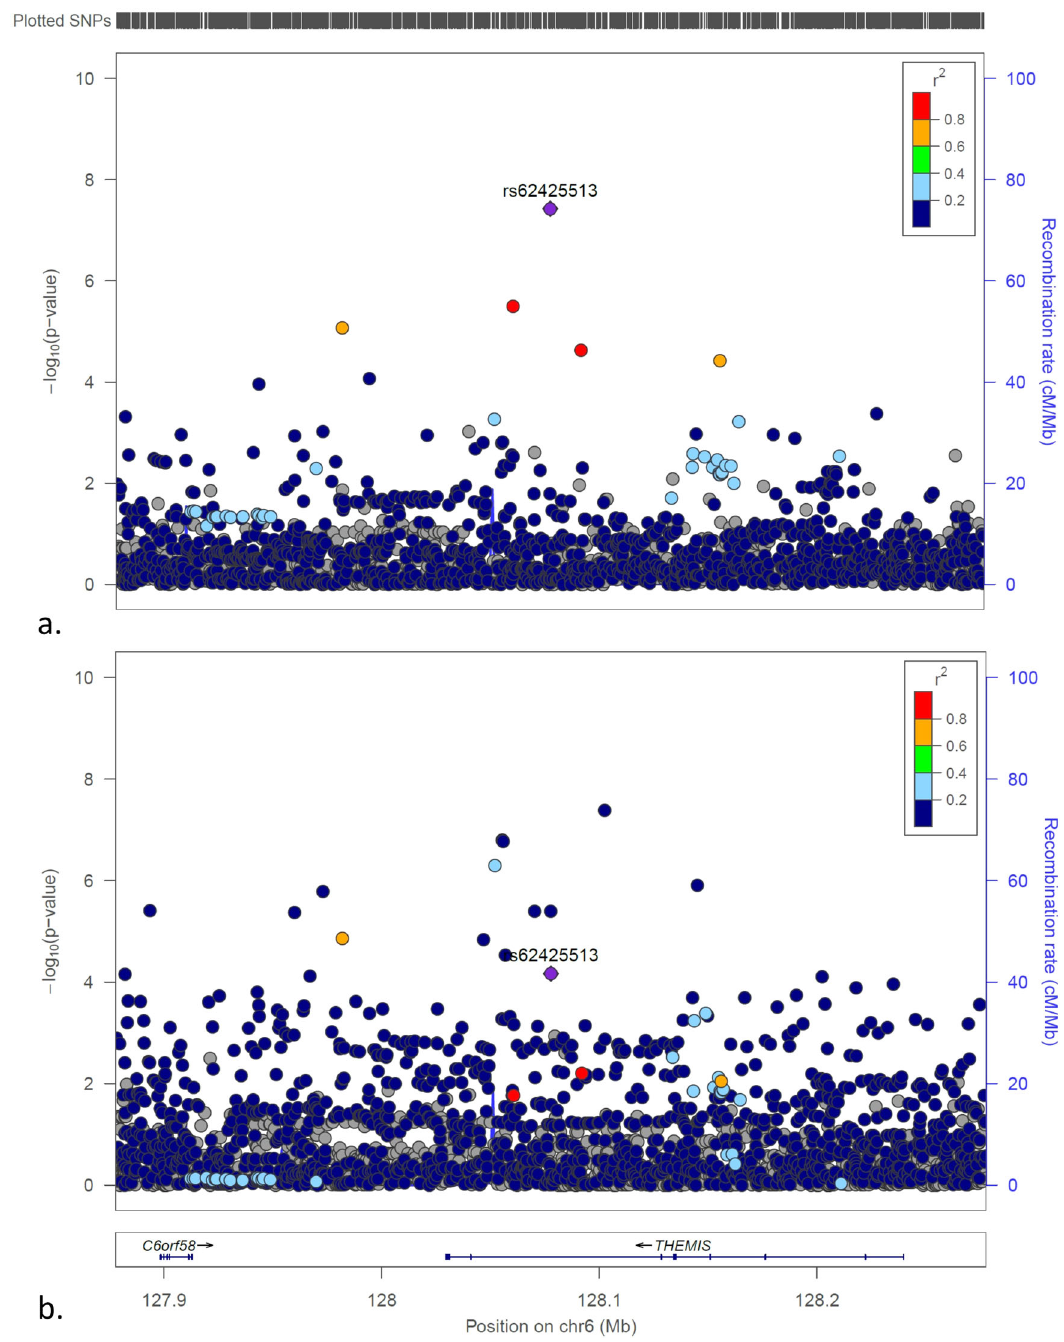
Fig. 5 The LocusZoom plots for the THEMIS locus. a The plot of the association tests of T1D patients with low T1D GRS compared to controls; ( b ) The plot of the association tests of all T1D patients compared to